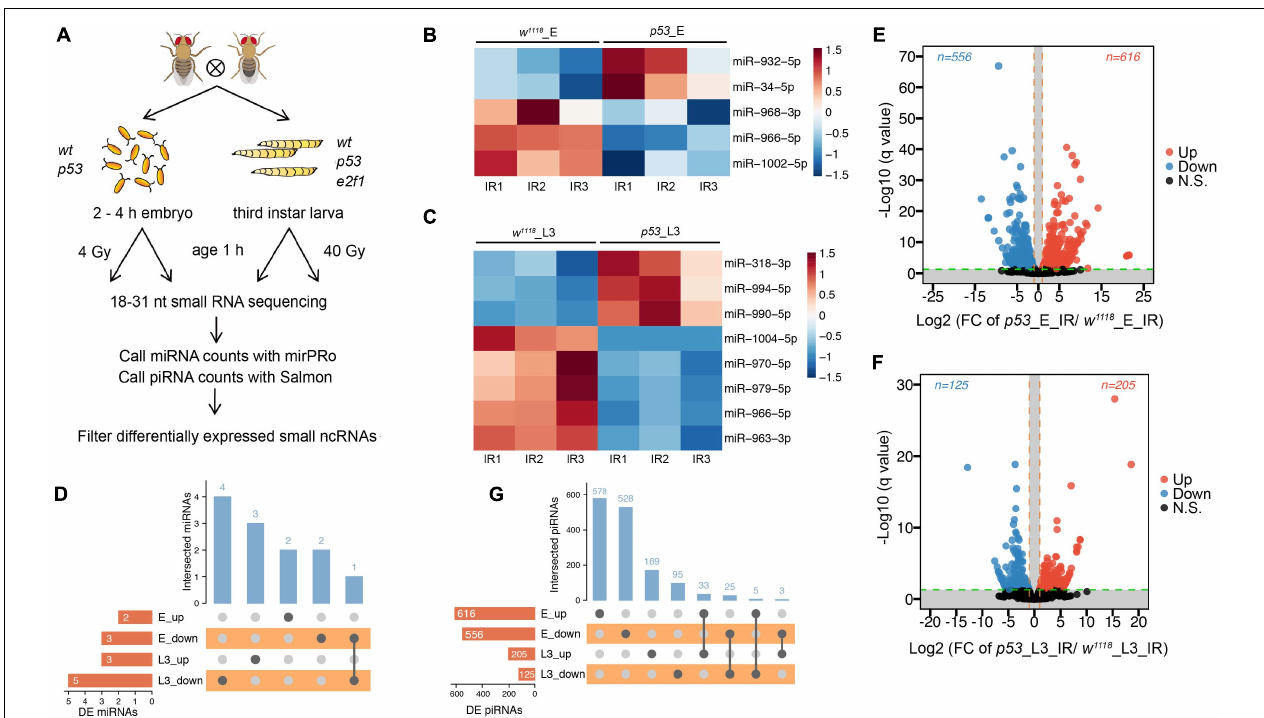
FIGURE 4 | DE miRNAs and piRNAs after X-ray irradiation in p53 mutant. (A) Schematic illustration of experimental design and time-points for samples collection. Heatmap of DE miRNAs after DNA damage in p53 mutant embryos (B) and L3 (C) . (D) UpSet plot depicting the number of DE miRNAs in response to DNA damage in p53 mutant embryos and L3. Volcano plots of piRNAs differentially expressed between wild-type flies and p53 mutant embryos (E) or L3 (F) after X-ray irradiation. (G) UpSet plot depicting the number of DE piRNAs in response to DNA damage in p53 mutant embryos and